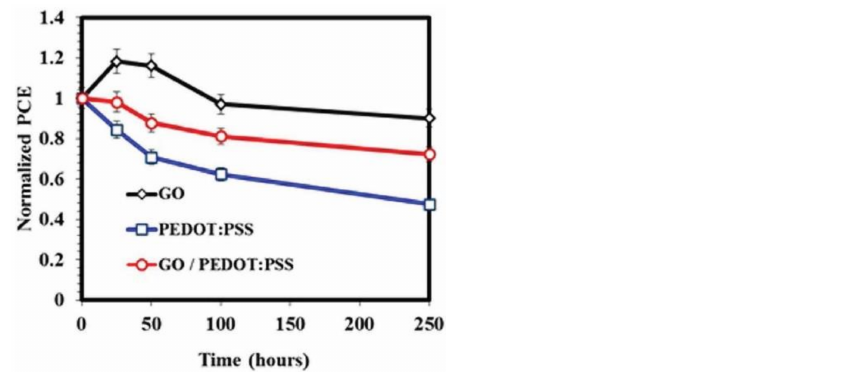
Figure 17. Stability test of various OSCs over 250 h. Adapted with permission from [328].